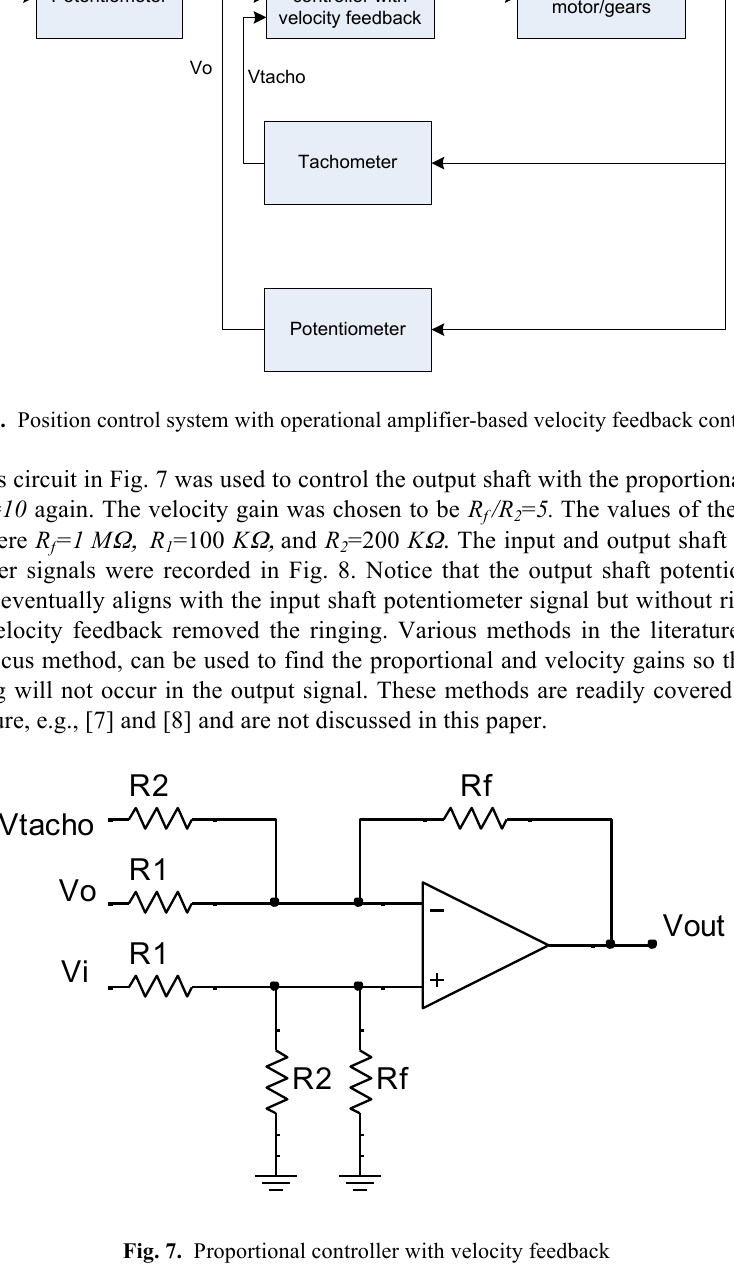
Fig. 7. Proportional controller with velocity